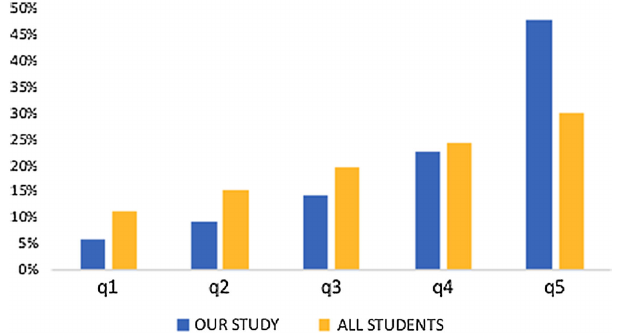
FIG. 4. Estimated parental income of samples from our study (blue) versus overall college student population (orange), by quintiles. Blue bars are constructed from university-level data pulled from the Equality of Opportunity Project [75,76], weighted by sample size. Orange bars are constructed from percentages cited in Ref.